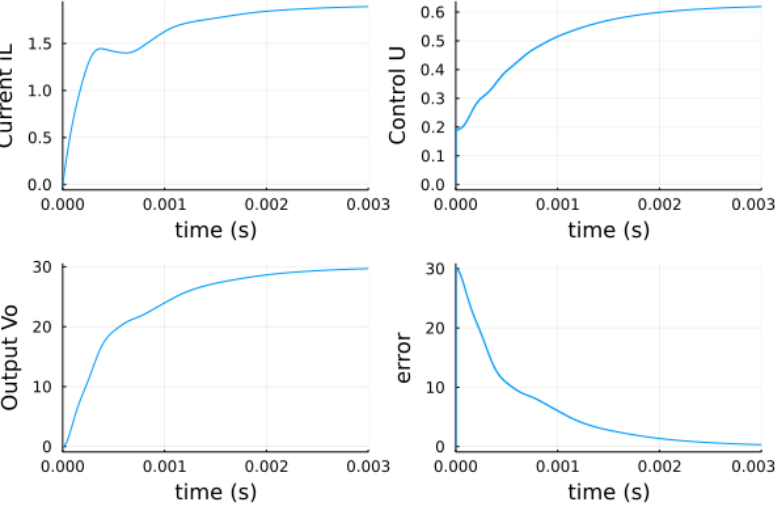
Figure 3. Output responses of the Buck converter controlled by the linear PID: inductor current i L , output voltage V o , control signal U , and instant